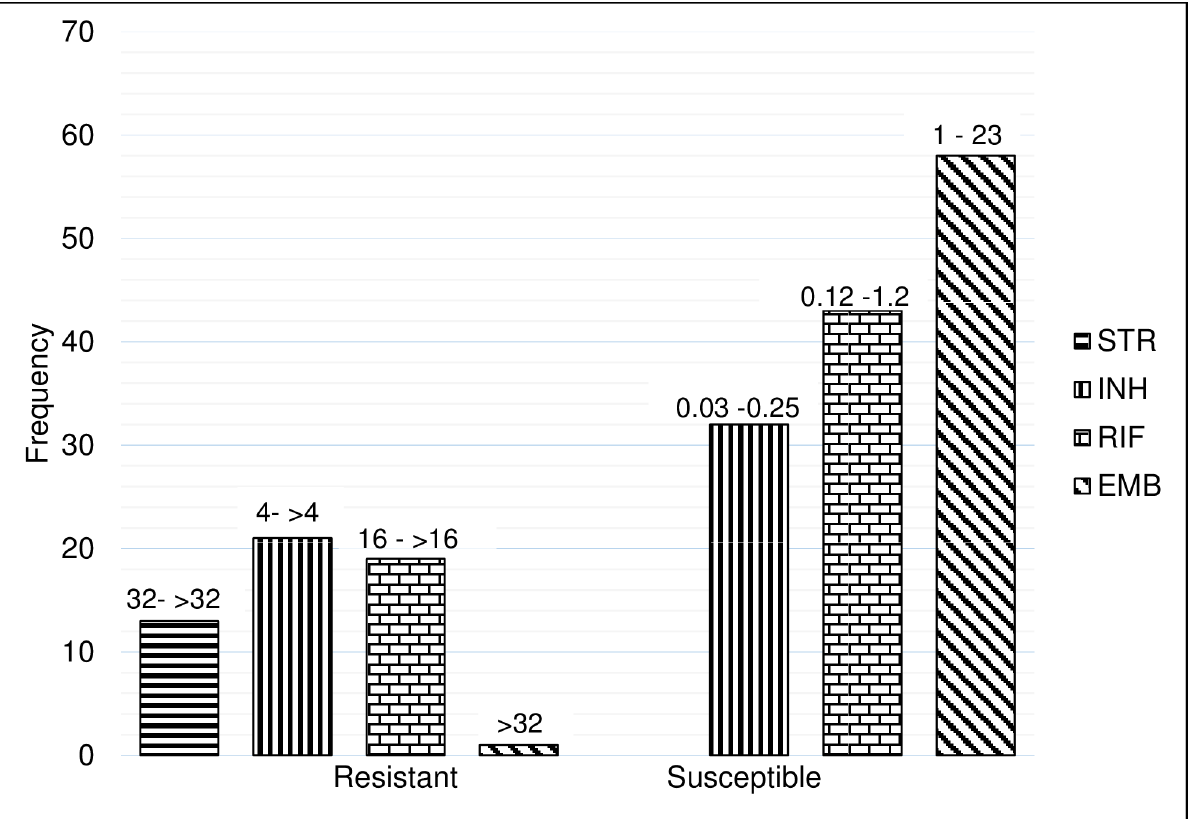
Fig 2. Shows Mycobacteriumtuberculosis isolates resistant and susceptible by all methods with their corresponding MIC range per first line drug. STR = streptomycin, INH = isoniazid, RIF = rifampicin, EMB =